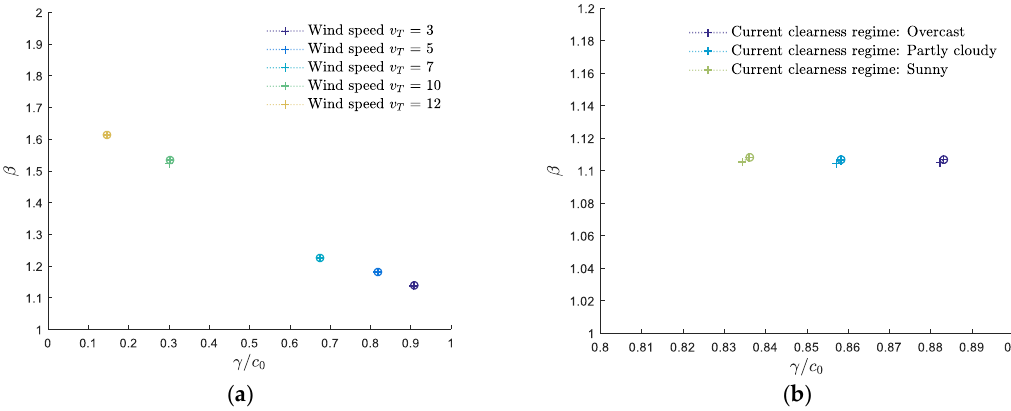
Figure 4. Convergence of value function parameters for different wind speeds for the case of wind power ( a ) and for different cloud cover conditions (clearness regimes) for the case of PV ( b ).